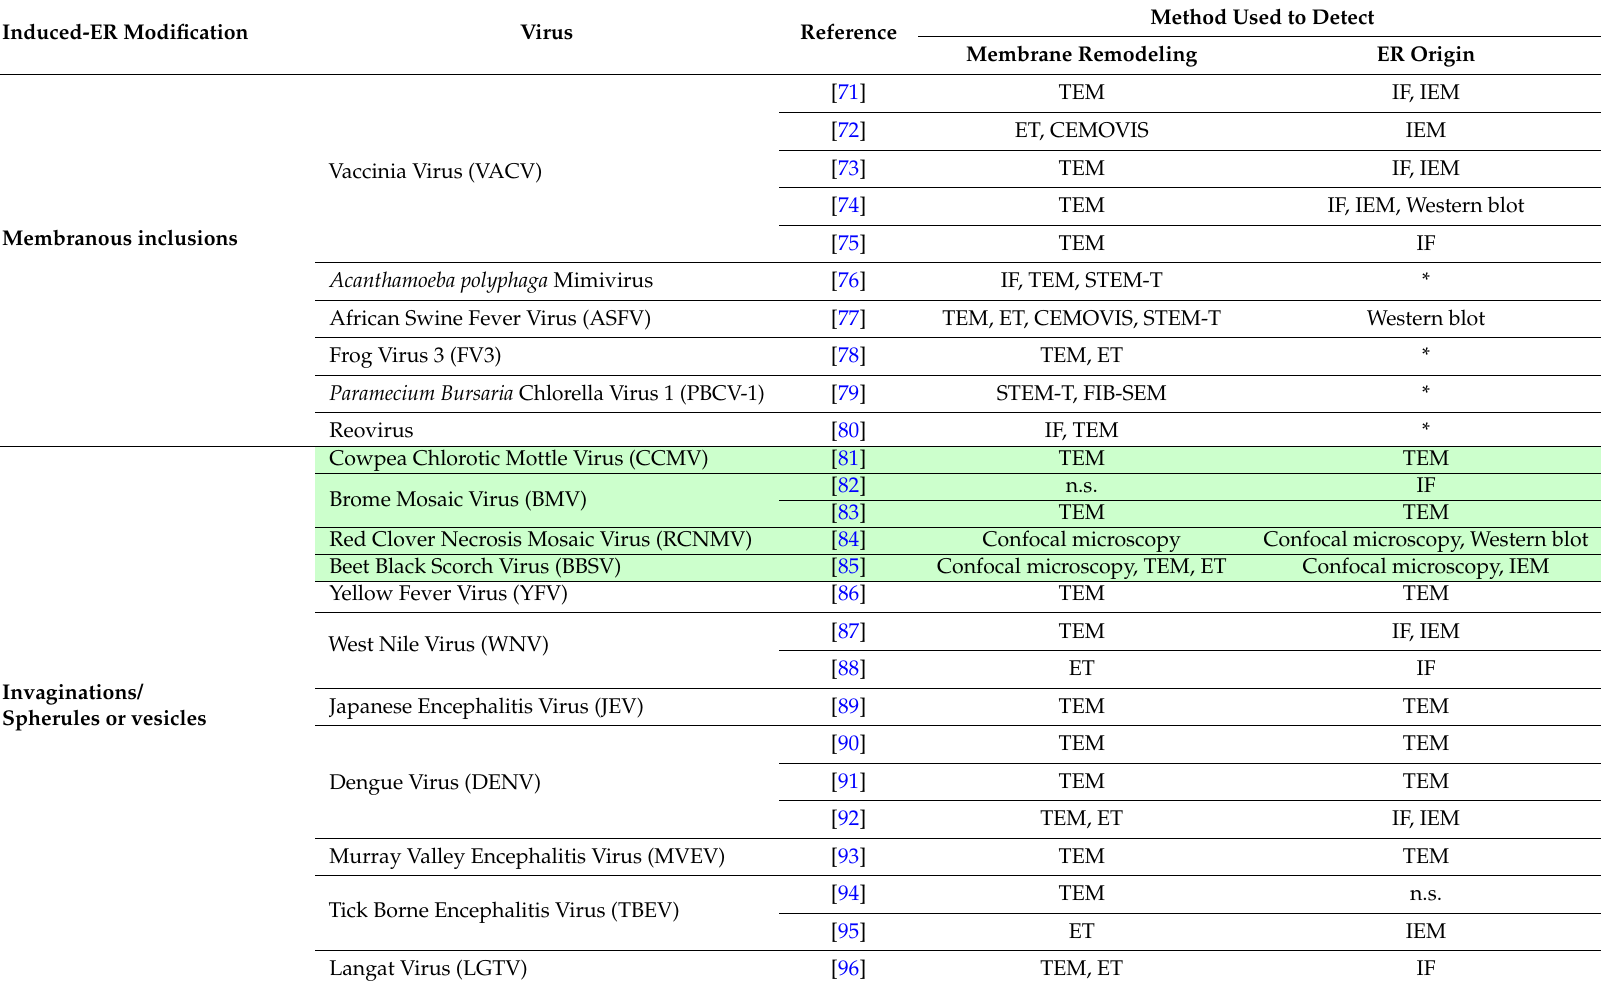
Table 1. Virus-induced endoplasmic reticulum (ER)